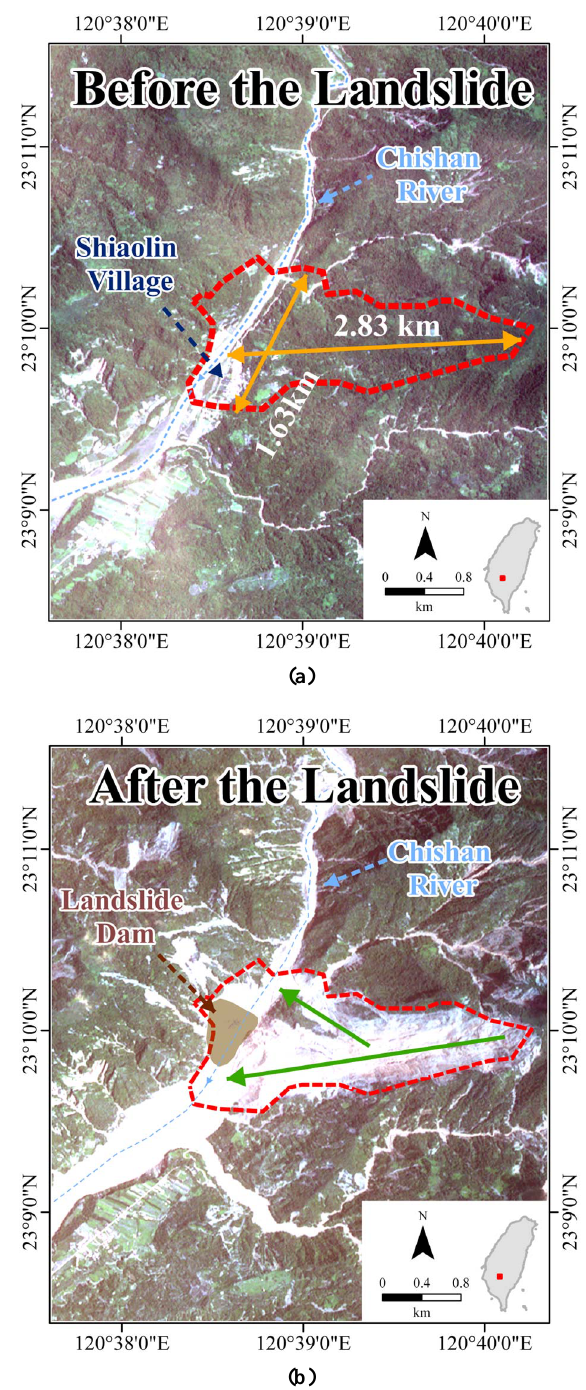
Figure 1(b) The landslide area and the landslide dam after the Shiaolin landslide, August 9, 2009 (SPOT image August 24, 2009). The red dotted line indicates the Fig. 1. (a) The Shiaolin village and Chishan River prior to the Shiaolin landslide zone, and the green arrows indicate the sliding directions. Shiaolin landslide (SPOT image from 22 June 2008). The red dot- ted line indicates the Shiaolin landslide zone. (b) The landslide area and the landslide dam after the Shiaolin landslide, 9 August 2009 (SPOT image 24 August 2009). The red dotted line indicates the Shiaolin landslide zone, and the green arrows indicate the sliding